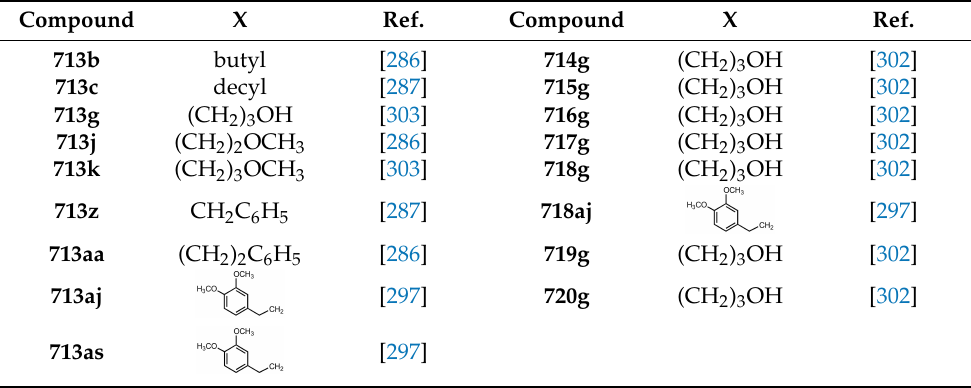
Table 4). Table 4. A series of D -galactoside-based aza-crown ethers synthesised by Bak ó and co-workers. Compound